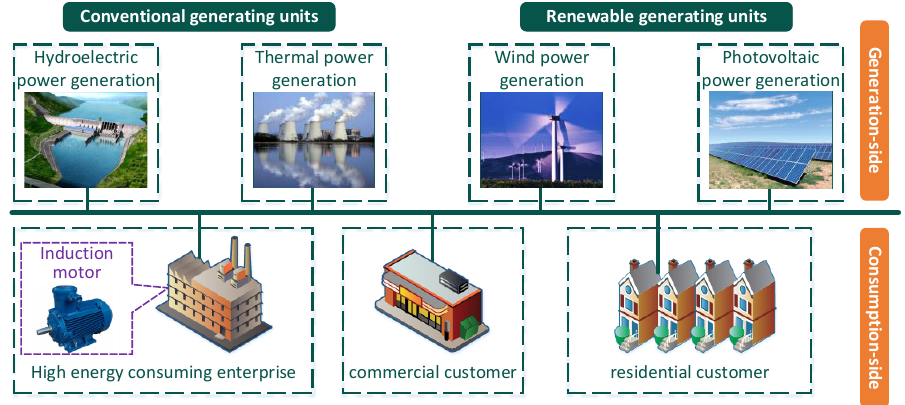
Figure 2. Diagram illustration of generation-side units and consumption-side customers in a power